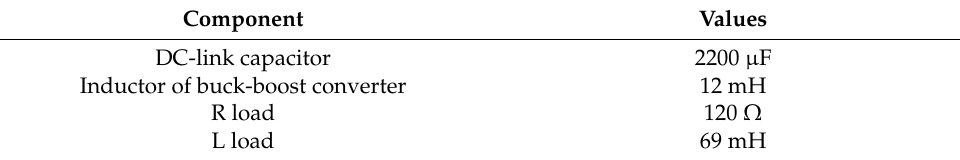
Table 1. Values of circuit